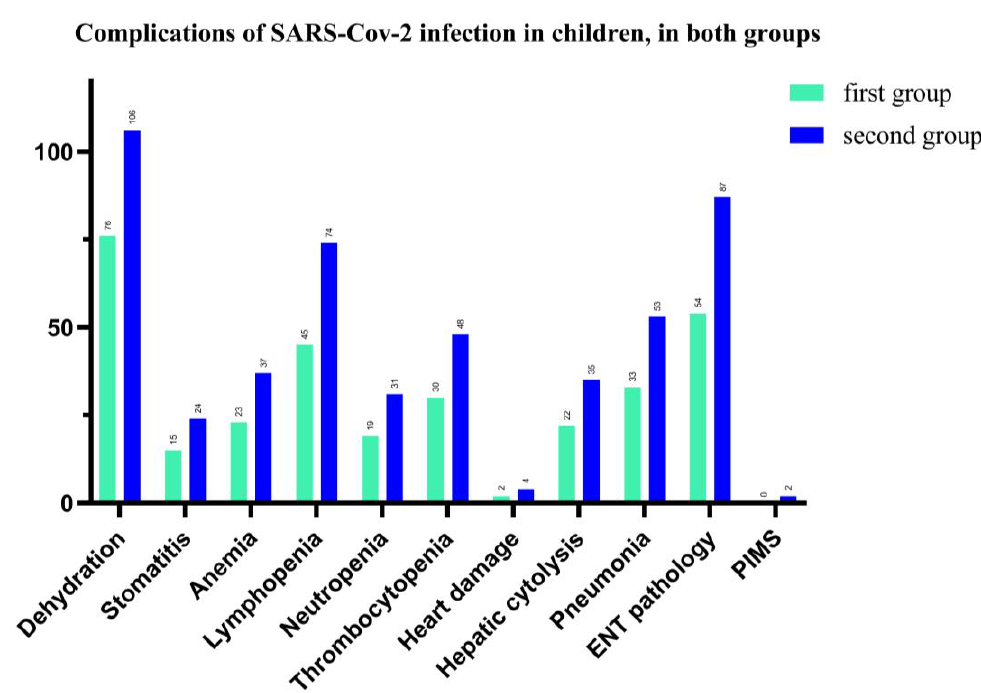
Figure 6. Number of cases with complications of SARS-CoV-2 infection in hospitalized pediatric patients. According to the severity classification described by Parri, adapted by Dong et al., (see Table 1), we reported 51% vs. 44.6% mild forms, 59% vs. 65.4% moderate forms, and 0 critical forms.